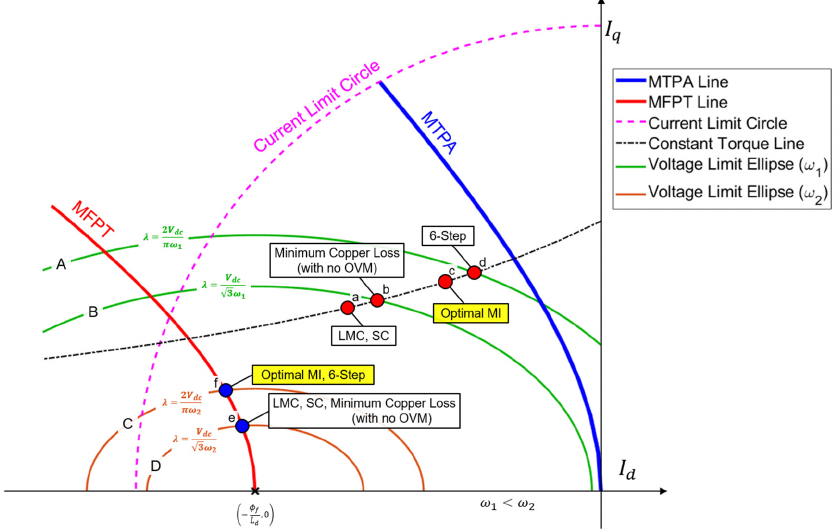
Figure 2. Comparison of current operating point selection strategies used in previous studies.